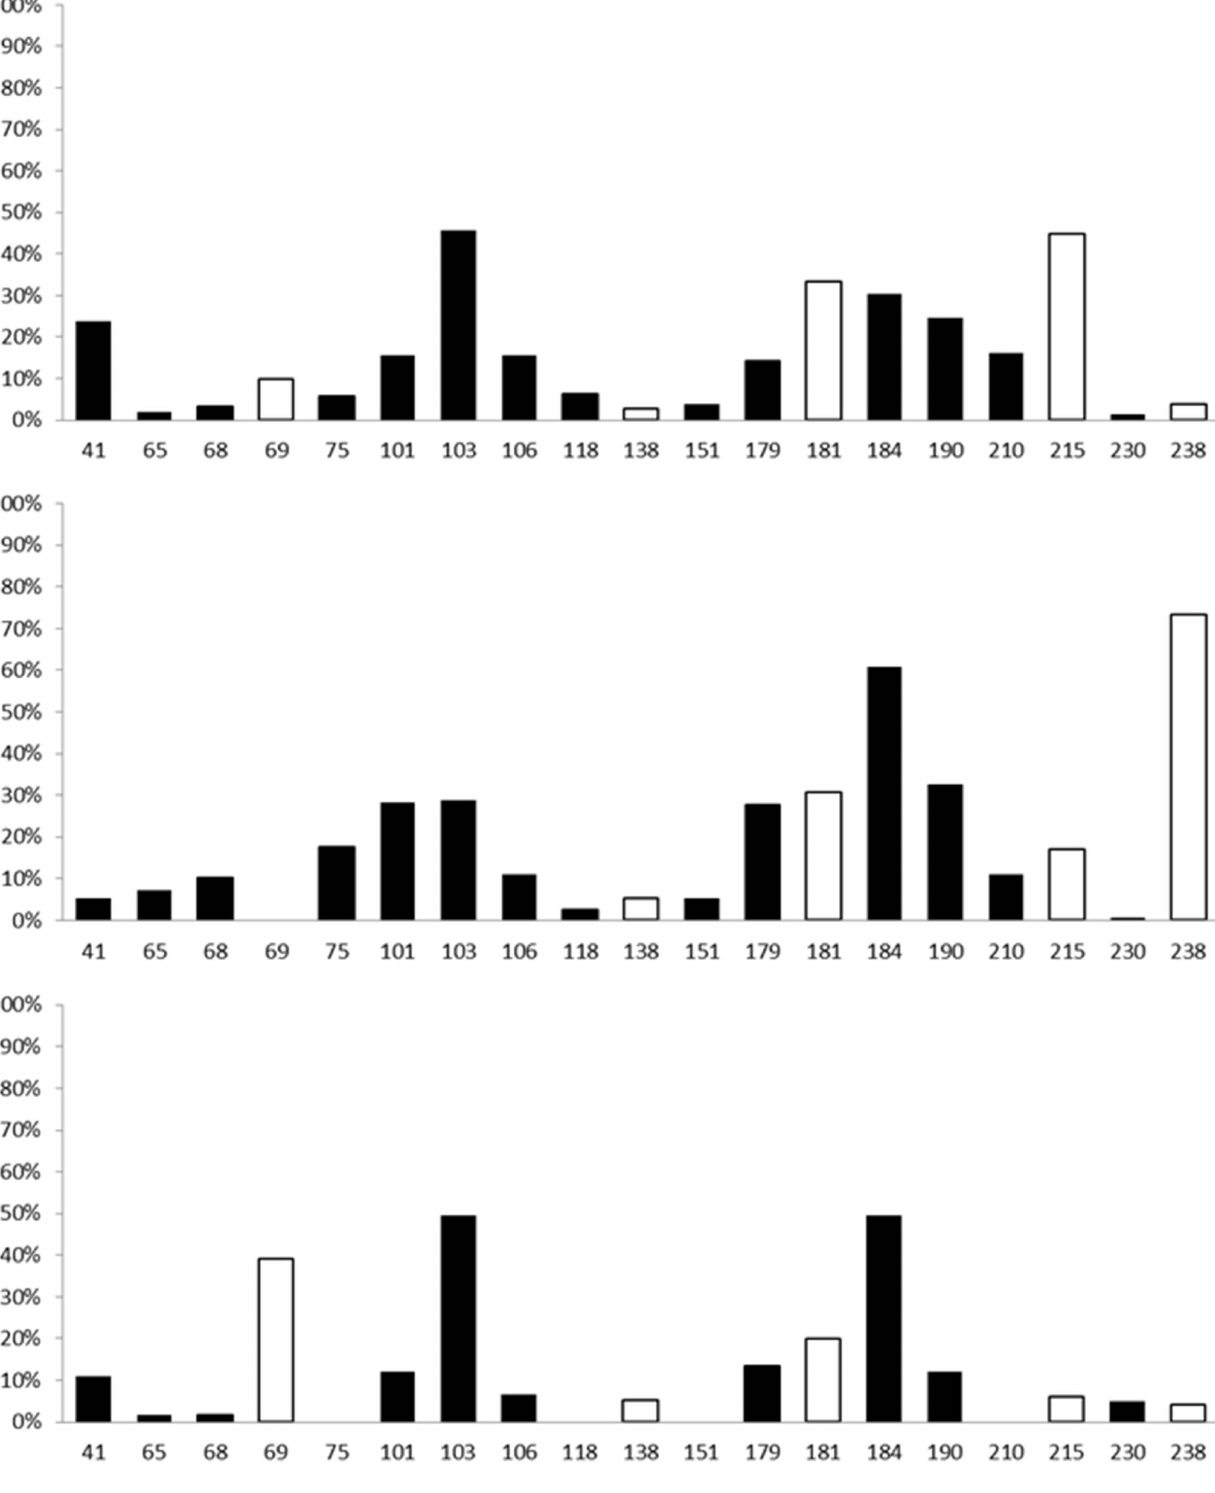
Figure 1. Subtype-specific drug resistance mutation sites analysis. Note: horizontal numbers indicate drug resistance mutation sites in RT region with significant difference among subtypes, vertical percentage indicate the proportion of mutated amino acids differ from the subtype B consensus sequence. Black columns means only amino acids distribution with significant difference among subtypes (chi-square or fisher’s exact test, p , 0.05), white columns means both mutated amino acids distribution and genetic barriers with significant difference among subtypes (Kruskal Wallis test, p , 0.05).